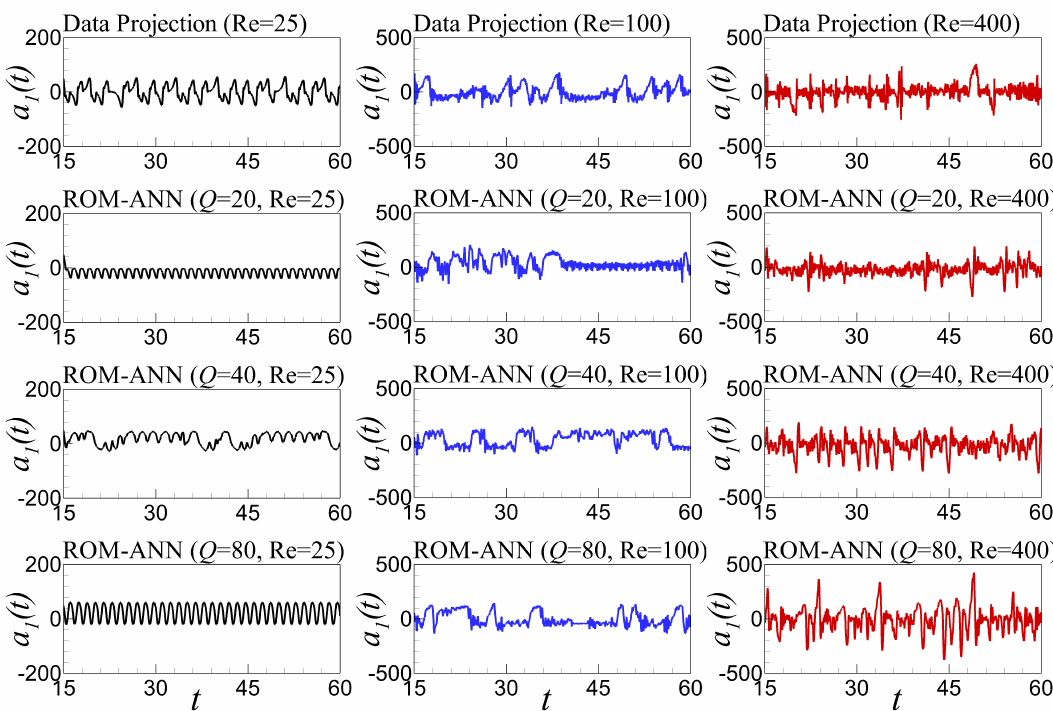
Figure 17. Sensitivity analysis with respect to the number of ELM neurons of fully non-intrusive ROM-ANN approach using time series of the first modal coefficient, a 1 ( t ) for Re = 25,100,400 and Q = 20,40,80.